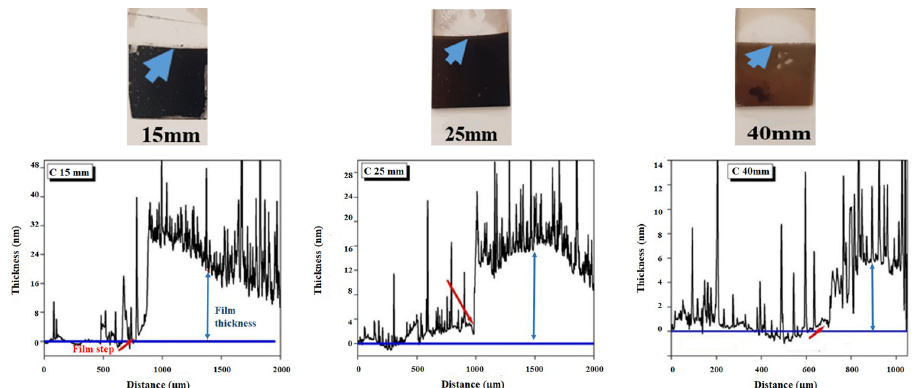
Fig 5. Optical images of carbon coatings deposited on soda-lime glass at a distance of 15, 25 and 40 mm from the carbon source with correlative profilometry measurements of carbon films deposited on soda-lime glass placed 15, 25 and 40 mm from the carbon rod. The glass level is indicated by the blue baseline, with the film step and thicknesses indicated by red arrows. The red and blue arrows correspond with each other, indicating the same place where the coating has taken